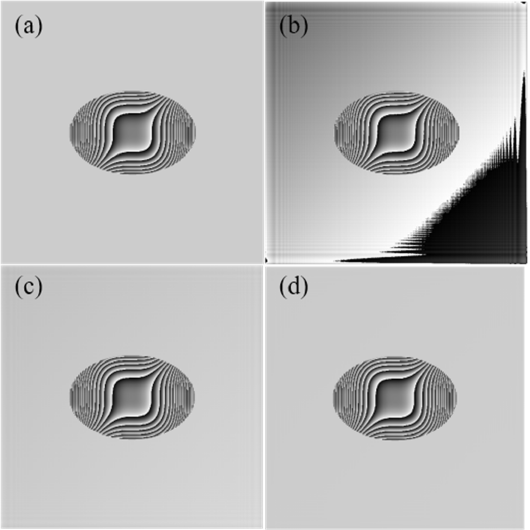
Figure 6. Phase object reconstruction results with different RTA errors ( a ) Ground truth, and by ( b ) DSM method, ( c ) LGF method, ( d ) LGF with ZPM. The RTA errors calculated by DSM are Δθ x = Δθ y = 4.4 × 10 − 5 rad and the object phase